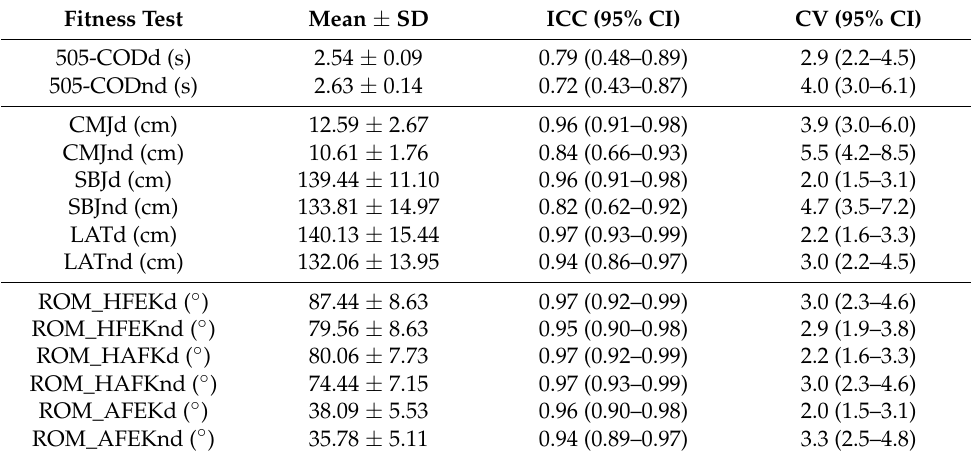
Table 1. Descriptive data (mean ± standard deviations (SDs)) and test reliability (95%